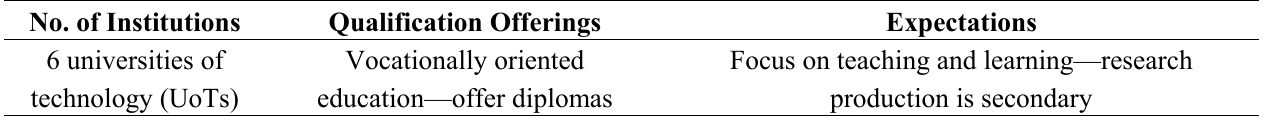
Table 1. South Africa’s re-landscaped higher education